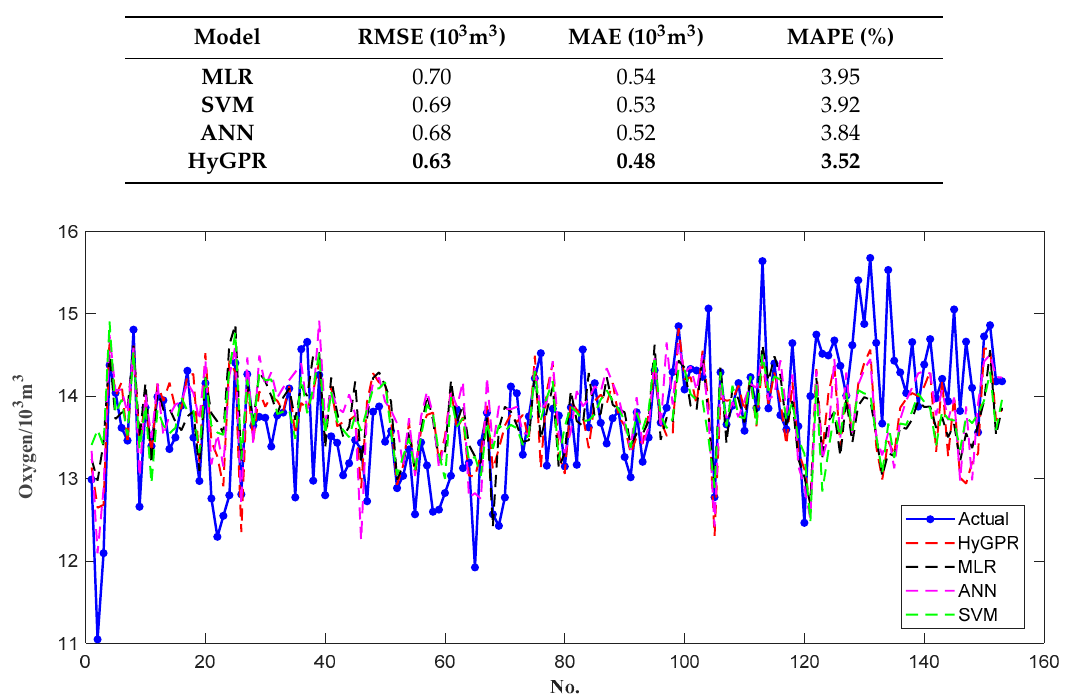
Figure 5. Point forecasting results of the oxygen consumption.